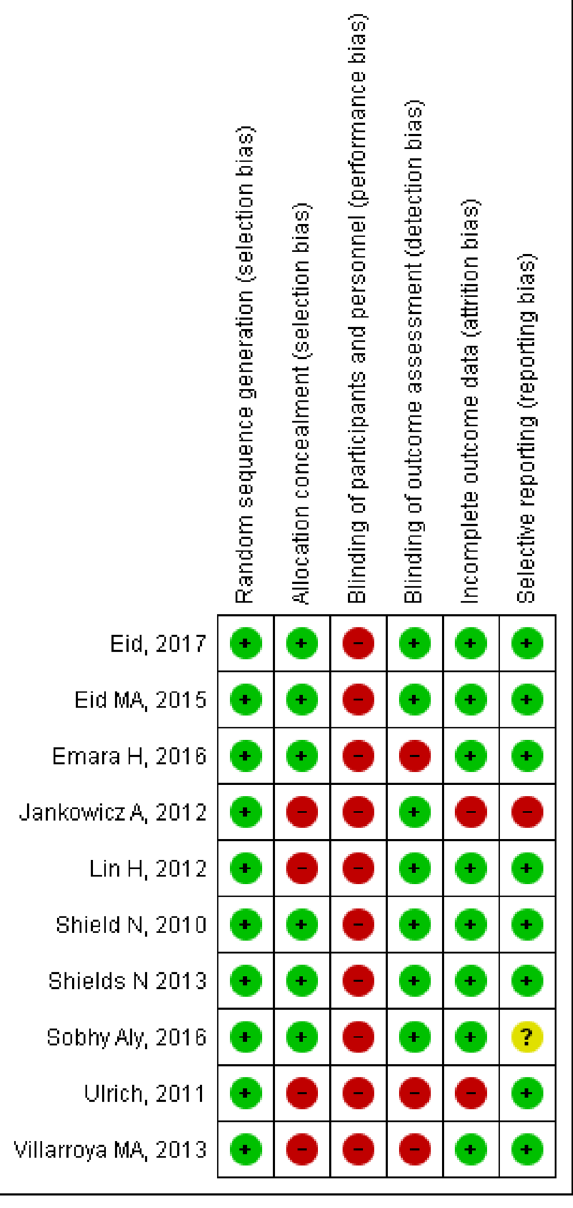
Figure 2. Risk of bias summary: review authors’ judgments about each risk of bias item for each included study. Revman 5. https:// train ing. cochr ane. org/ online- learn ing/ core- softw are- cochr ane- revie ws/